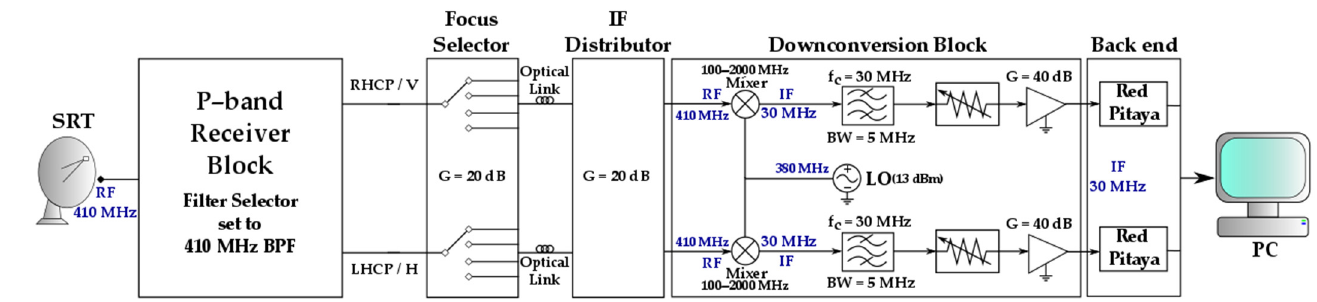
Figure 5. Schematic of the space debris dedicated channel of the SRT. RF, radio frequency. The dedicated back-end for space debris observations is composed of the down-conversion block, and, finally, the Red Pitaya. The down-conversion block lowers the 410 MHz frequency of the incoming signal to match the working frequency of the back-end (0–50 MHz). The down-converted signal is filtered and amplified. A digital step attenuator, controlled by the Red Pitaya, is located upstream to the final amplifier in order to avoid saturation of the system. The setting of the digital attenuator is calibrated upon the power level of the carrier, as explained in [13]. The last block of the dedicated channel is the Red Pitaya, a commercial system-on-a-chip FPGA board provided with a dual-core 800 MHz ARM9 processor, a FPGA with 28,000 logic cells, 512 MB of DDR3 RAM system memory, 2 RF inputs and 2 RF outputs, an overall 3 dB-bandwidth of 50 MHz, a sample rate of 125 M Sample/s, and 14 bit of ADC resolution. A digital signal processing chain was built inside the board, allowing the conversion of the input signal in a base-band complex signal. This raw signal can be stored and post-processed using an FFT engine and, finally, displayed on a computer. 3. Results and Discussion Between 13 December 2018 and 10 October 2019, the BIRALET system was able to observe a total of 27 objects. The Italian Air Force (Aeronautica Militare—AM) has pro- vided the list of objects to observe, making sure to include a wide variety of samples in terms of RCS and range. All the observations were made in a variant of the beam-park mode. Usually, the beam-park mode (or stare mode) is employed for the survey of space debris, illuminating a specific portion of the sky and waiting for the objects to cross the field of view (FOV) of the antenna. It is employed very often to detect objects that are not part of a catalogue. In this case, the aim was not to detect uncatalogued objects, but to assess the capabilities of the radar system. Furthermore, the characteristics of the BIRALET system are not suitable for survey purposes, owing to the narrow beam. Thus, the antenna was pointed each time in a different direction, dictated by a specific object in the list, and waited for its passage. Before the observations, a forecasting simulation was made in order to obtain the azimuth and elevation pointing coordinates and to estimate the Doppler shift values. An algorithm based on the reading of the TLEs provides these pieces of information. The results of the campaign are summarized in Figures 6 and 7, representing the RCS as a function of the range and the altitude as a function of the elevation pointing angle, respec- tively, for the 27 detected objects.